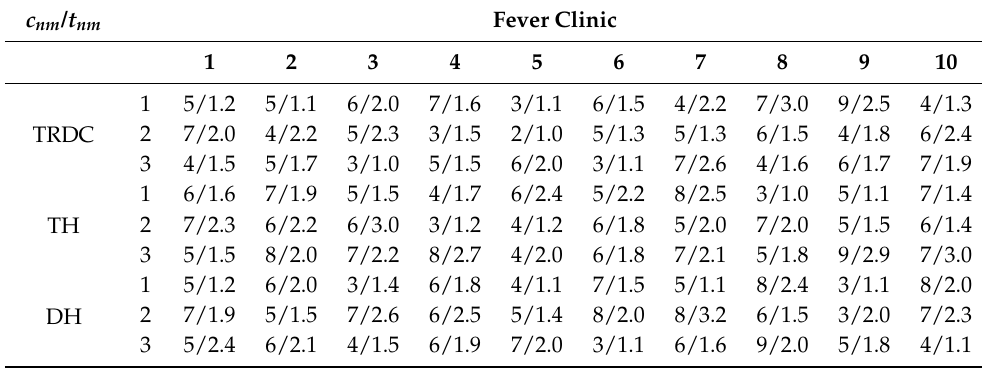
Table 4. Transportation cost and time distance.